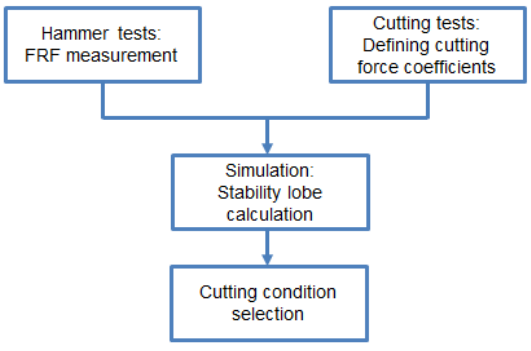
Figure 1. Illustrations of the cutting condition selection.